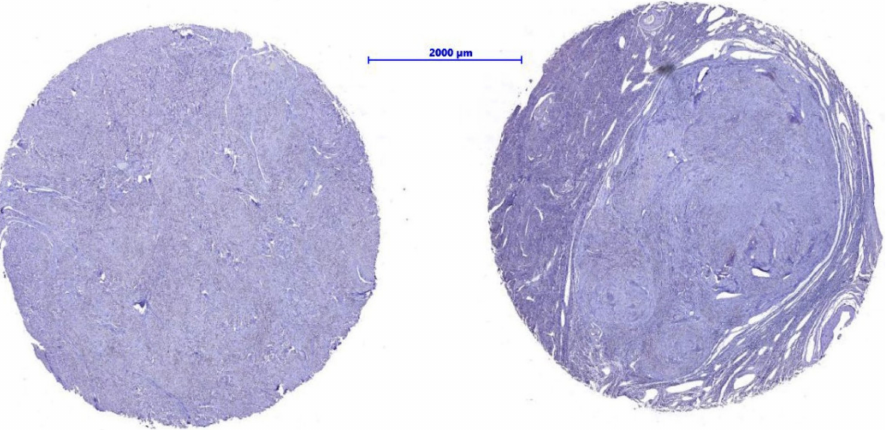
Figure 2. Example of fibroid and tumor margin, stained with H&E, 250 ×